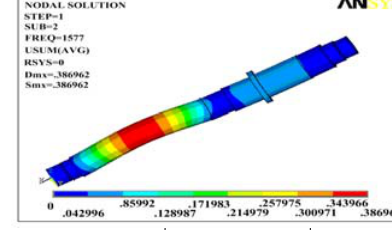
Fig.6. the 2 nd mode of the 2 nd shaft